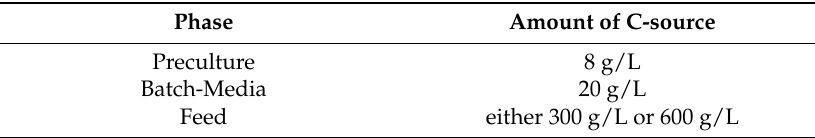
Table 1. Respective sugar concentrations in media